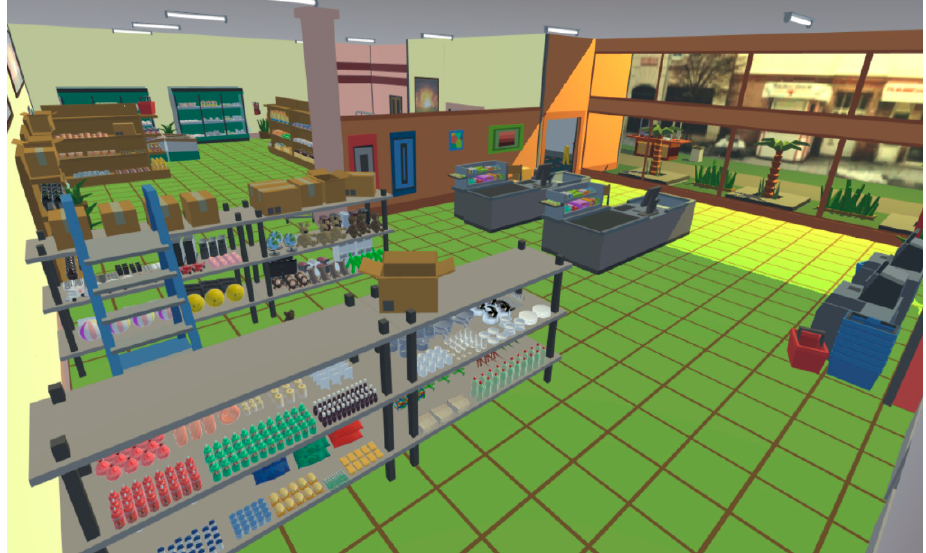
Figure 1. Virtual supermarket shopping task (VSST). Overview of the virtual supermarket